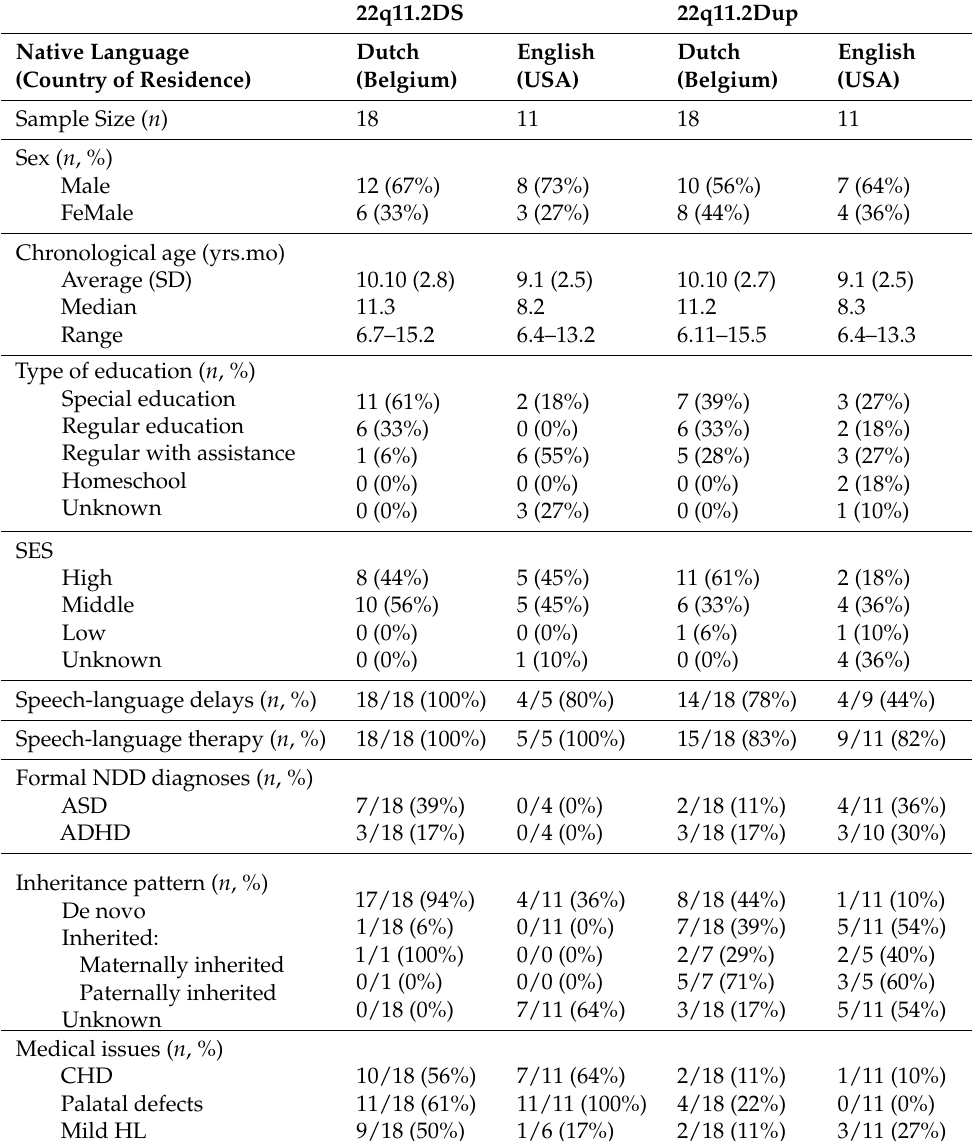
Table 1. Demographic and clinical features across